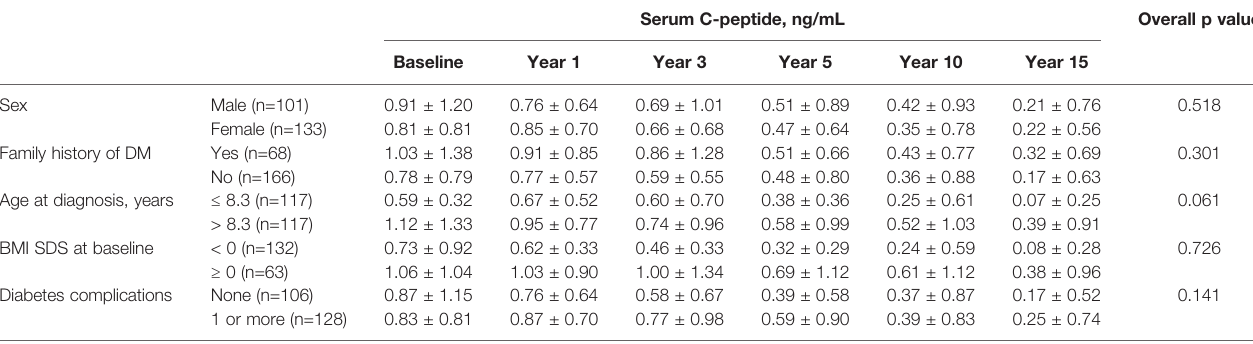
TABLE 2 | Factors associated with serum C-peptide.